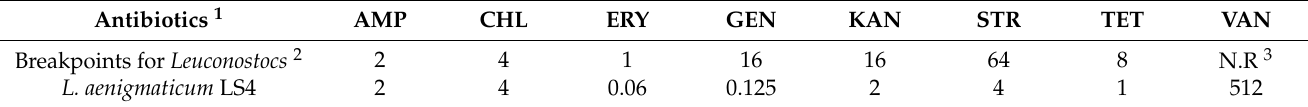
Table 3. Minimum inhibitory concentrations (MICs) of antibiotics for L. aenigmaticum LS4. Antibiotics